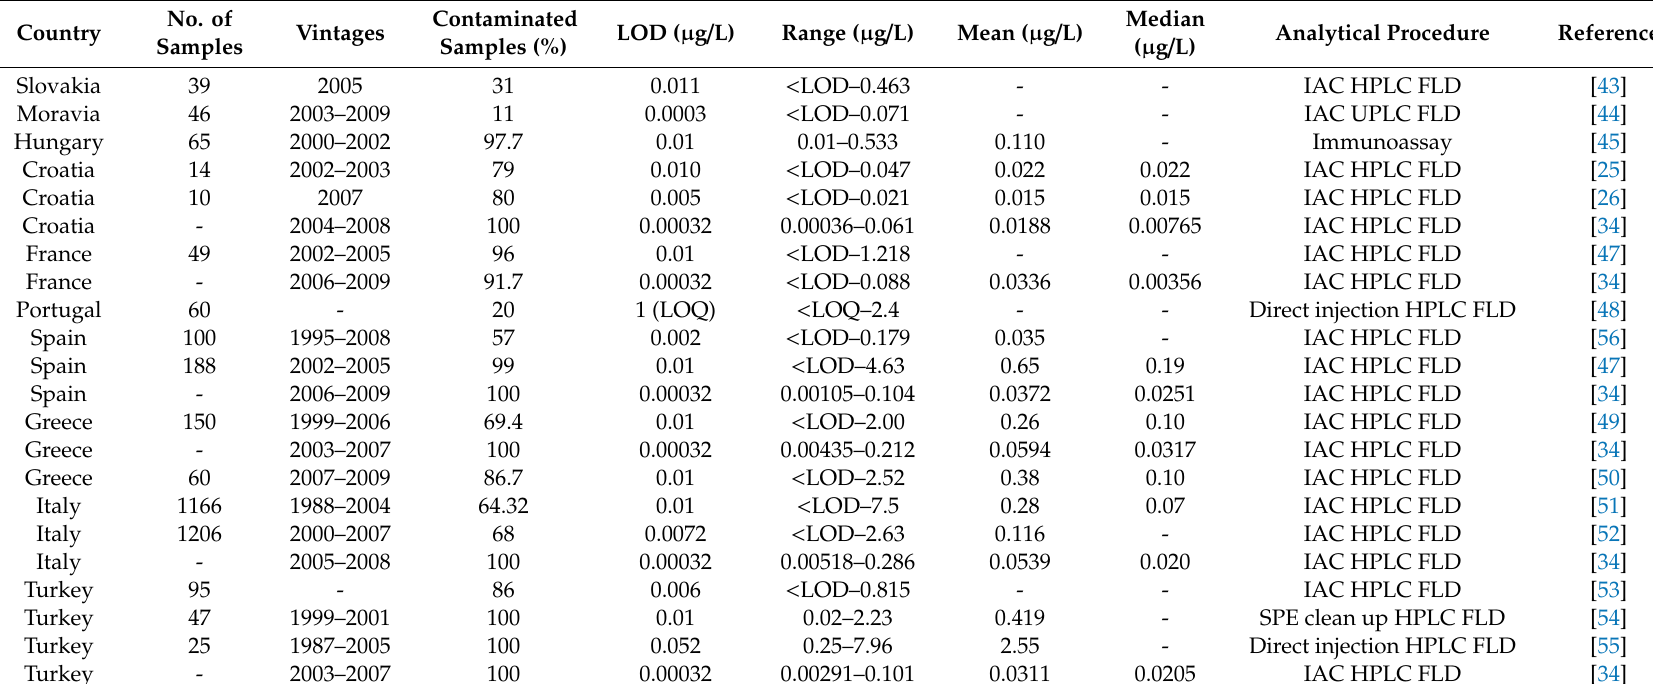
Table 5. Ochratoxin A incidence of wine contamination and concentrations measured in wine from previous